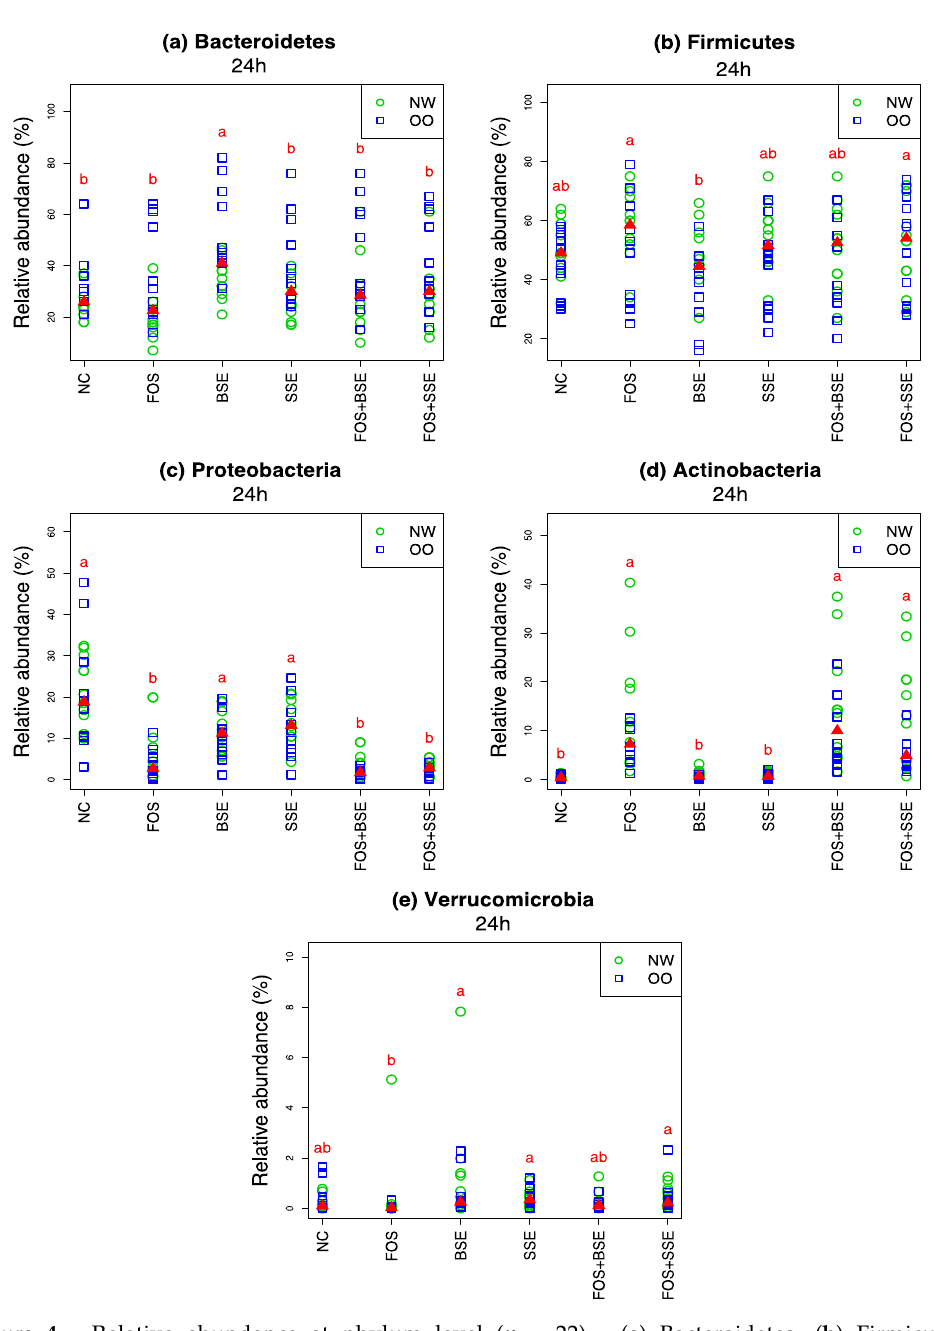
respectively ( p < 0.05) (Table 3). Compared to FOS, relative abundance of Verrucomicrobia increased in BSE, SSE and FOS + SSE after 24 h of in vitro fermentation ( p < 0.05) (Figure 4).